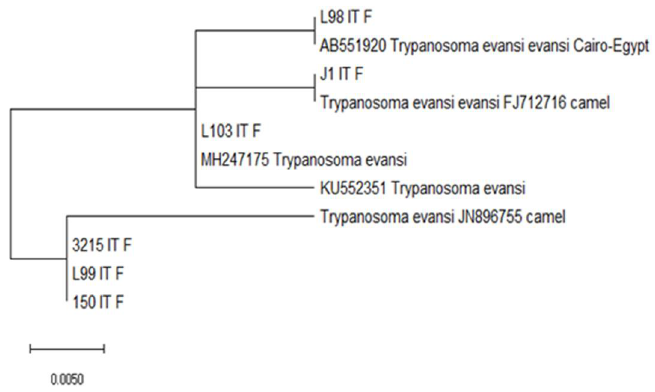
The phylogenetic tree based on the sequence of the ITS-1 region indicated that the T. evansi obtained was related to the T. evansi detected in camels from Egypt (AB551920), China (FJ712716), Iran (JN896755) and Kenya (MH247175) (Figure 4, Table 2).